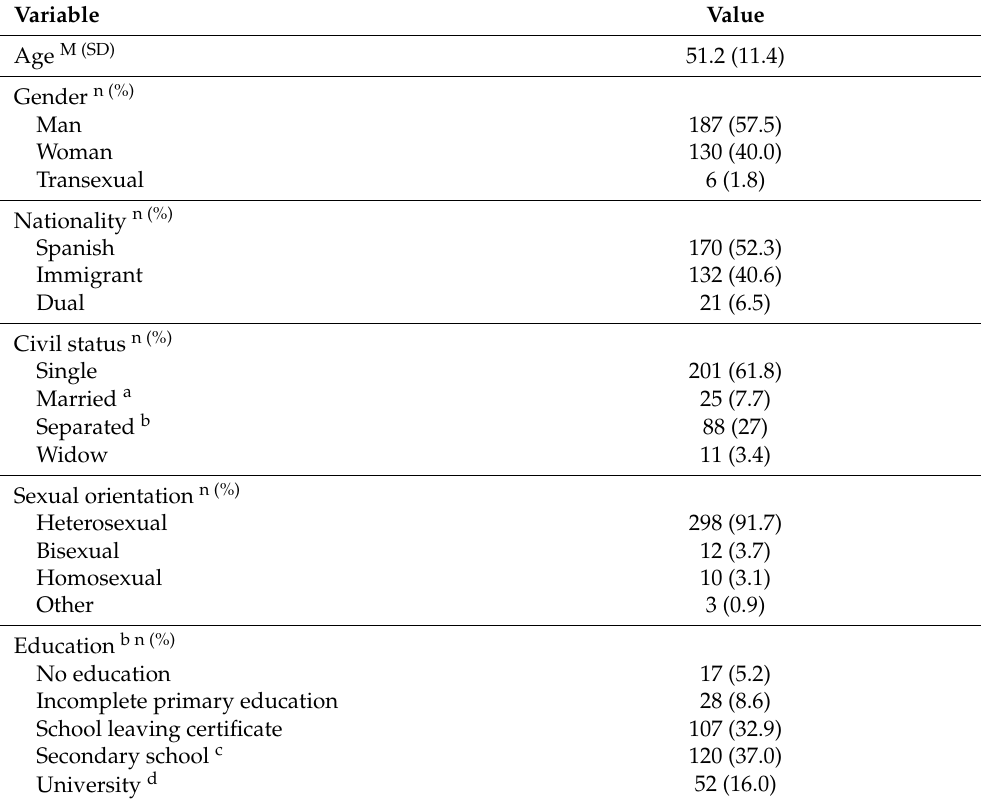
Table 2. Sociodemographic characteristics of the sample of